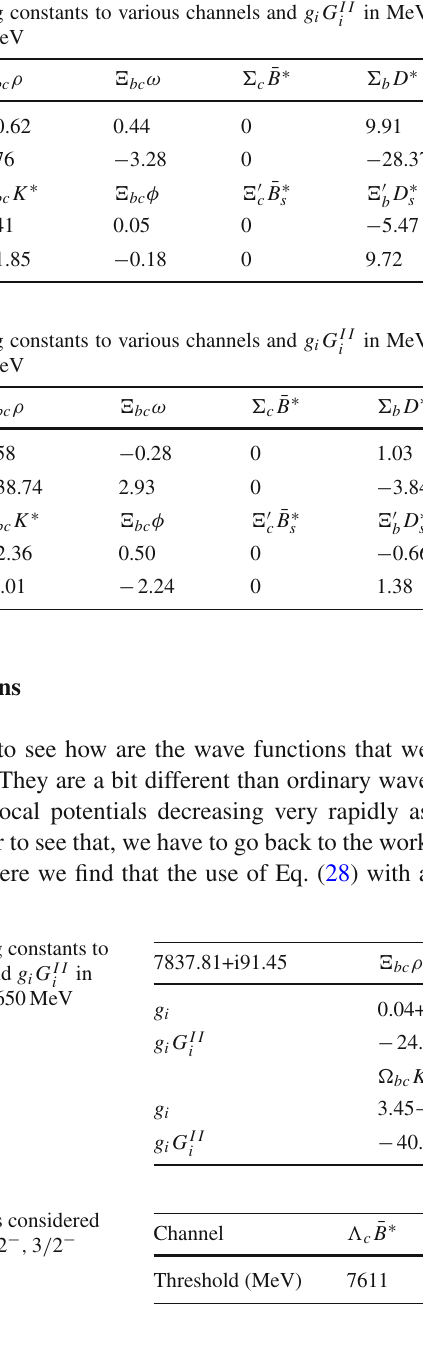
Table 22 Channels considered for sector J P = 1 / 2 − , 3 / 2